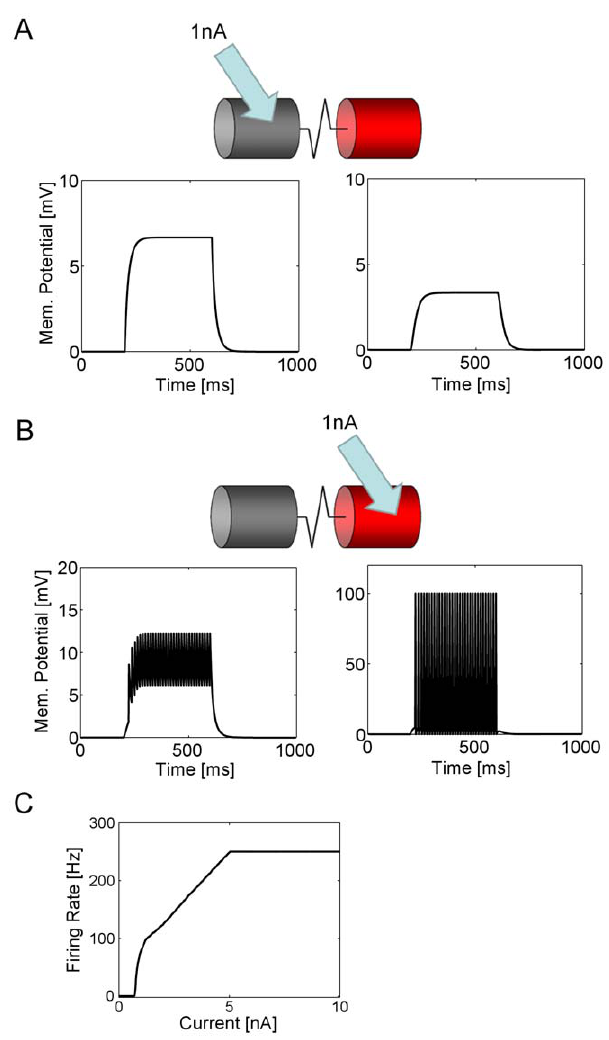
Figure 2. Passive and active properties of isolated model neurons. a A current of 1 nA is injected into the dendritic compartment. This results in a depolarization of about 6.7 mV. Roughly 3 mV depolarization is observed in the adjacent axonal compartment. b The same amount of current is injected into the axonal compartment directly. This elicits a train of action potentials which passively back- propagate into the dendritic compartment. Due to capacitive properties, the amplitude of the action potentials in the dendritic compartment is much reduced (note different scale on y-axis). c Action potential frequency is a function of injected current: After reaching spike threshold, the frequency rises steeply, then has a linear range before saturating at 250